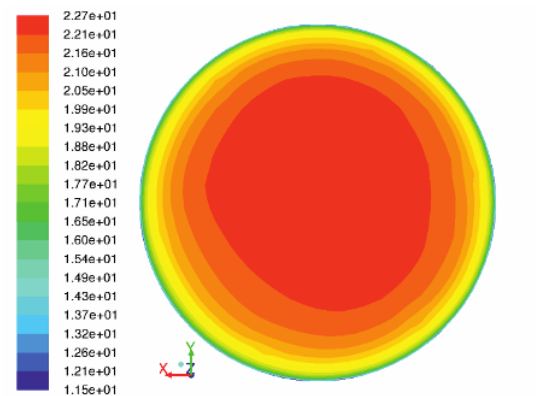
Figure 21: Average velocity distribution in metering run #3